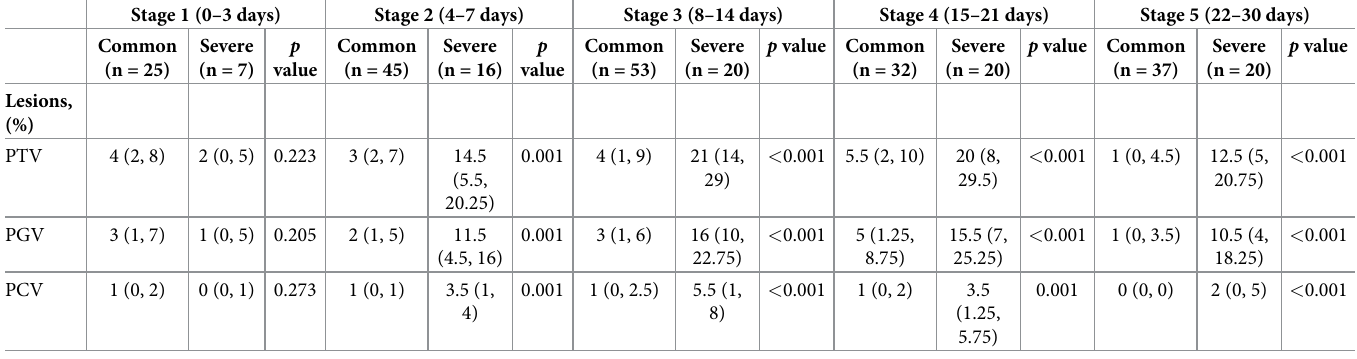
Table 2. Comparison of PTV, PGV and PCV between common and severe SARS-CoV-2 pneumonia among five stages. Stage 1 (0–3 days)